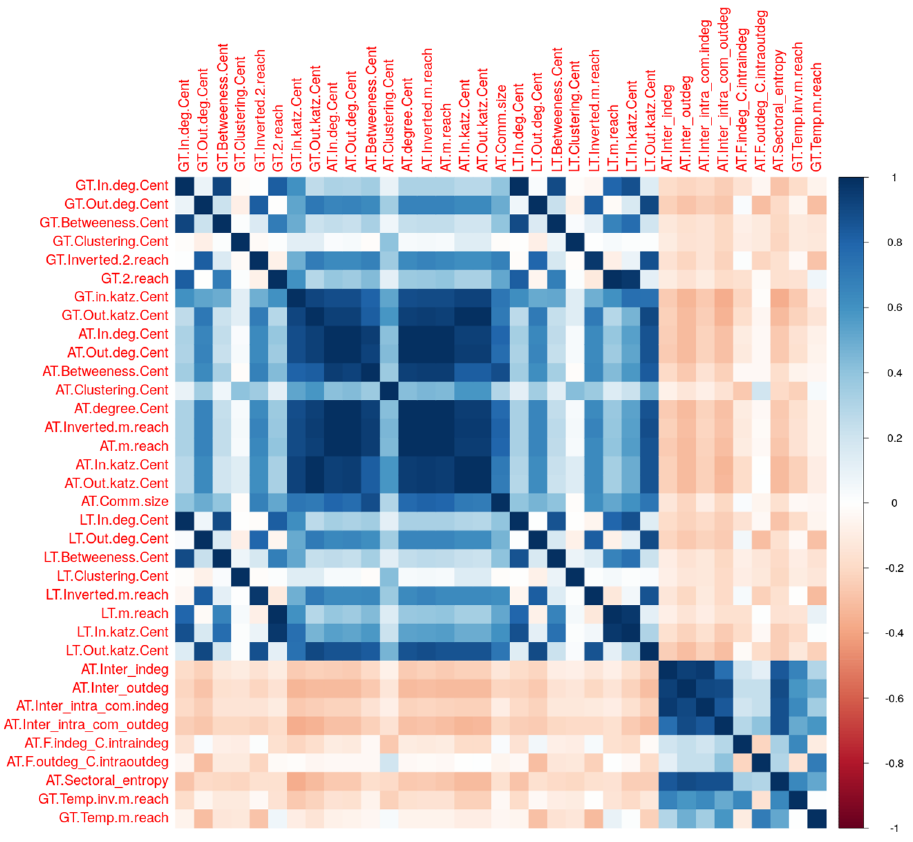
Figure 4. Correlation matrix of topological metrics. The table displays the correlation matrix among the centrality measures.